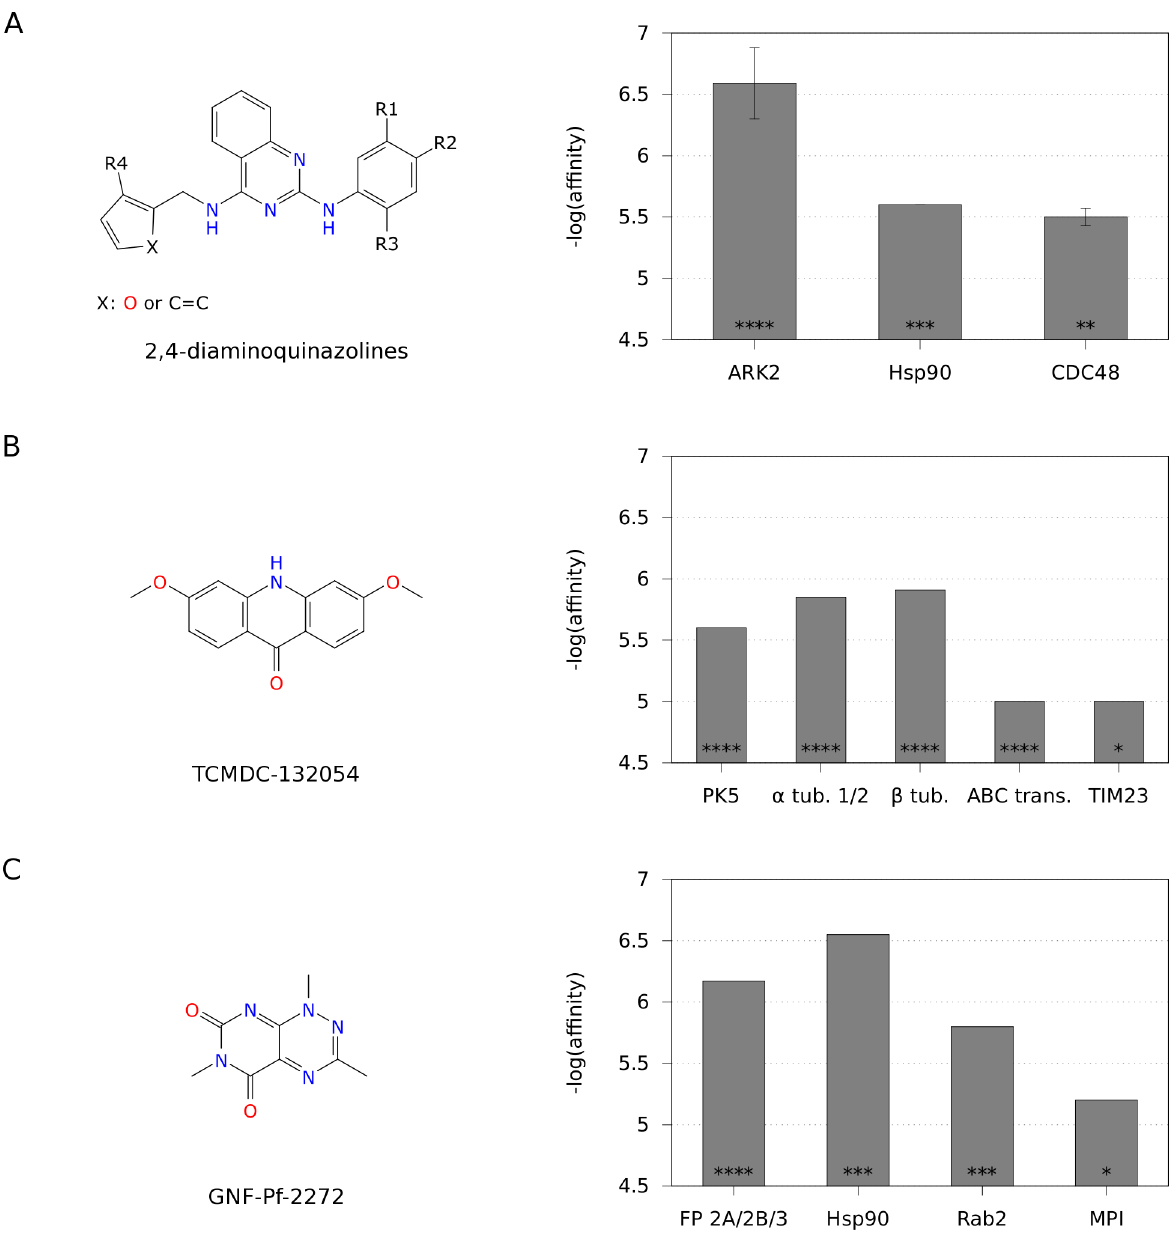
Figure 6. Selection of diverse multi-target profiles. The structures shown correspond to (A) the core scaffold of a set of 19 2,4- diaminoquinazolines, (B) TCMDC-132054, and (C) GNF-Pf-2272. The corresponding distributions of predicted affinities over multiple targets are provided on the right-hand side. For the set of 2,4-diaminoquinazolines (A), average predicted affinities are shown, with error bars giving the standard deviation over all compounds. Asterisks within the bars indicate the priority class of the respective target (‘****’=high priority, ‘***’=high affinity, ‘**’=enriched, ‘*’ predicted target). Targets of the same orthologous group are joined to a single bar.